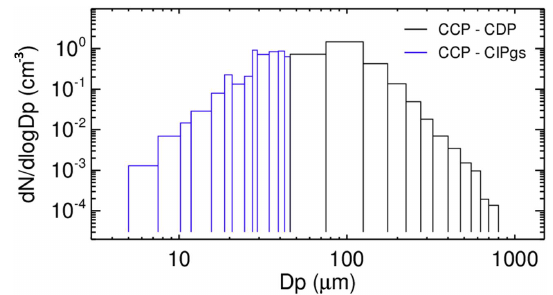
Figure 9. Number size distribution of a cirrus cloud, measured dur- ing the AIRTOSS campaign by the Cloud Combination Probe at the AIRcraft TOwed Sensor